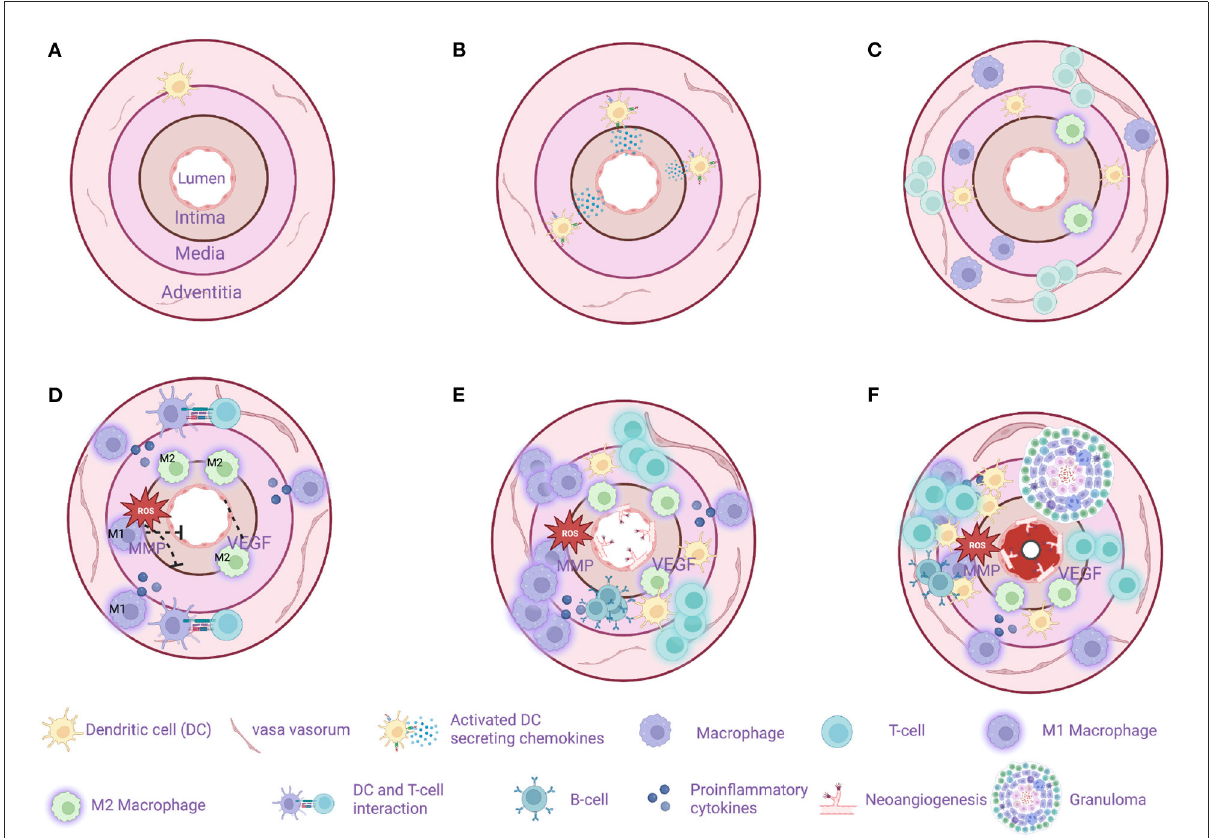
FIGURE3 Model of sequential steps in pathogenesis of giant cell arteritis. (A) A healthy temporal artery is devoid of macrophages and T-cells. Vascular dendritic cells (vasDCs) are located in the adventitia-media border as a part of the immunosurveillance system. (B) The immunotolerance in GCA breaks and the activated vasDCs migrate to the media where they produce chemotactic factors. (C) Macrophages and T-cells are recruited from the main circulation probably entering the artery through the vasa vasorum. MMP-9 producing monocytes as well as the VEGF-NOTCH1-Jagged1 pathway facilitate the migration of macrophages and T-cells. (D) M1 macrophages located in the adventitia produce proinflammatory cytokines maintaining the inflammatory response. M1 macrophages located in the media produce tissue destructive molecules such as MMP-9 and reactive oxygen species (ROS). M2 macrophages in the intima-media border produce angiogenic growth factors such as VEGF contributing to the dysregulated repair mechanism in GCA. T cells continue to infiltrate the artery’s layers with direction from adventitia to intima. (E) The destruction of the artery’s tissue continues, T-cell inhibitory signals as the PDL1-PD1 are weakened in GCA leaving the activation of T-cell unopposed. At the same time a dysregulated repair process is in progress with excessive neo-angiogenesis and fibrosis. In some cases, artery tertiary lymphoid organs are located in the media. (F) The final result of the chronic inflammation is the formation of granulomas (up to 75% of the examined temporal artery biopsies) and the progressive stenosis and in some cases occlusion of the artery due to a maladaptive response to injury. Created with